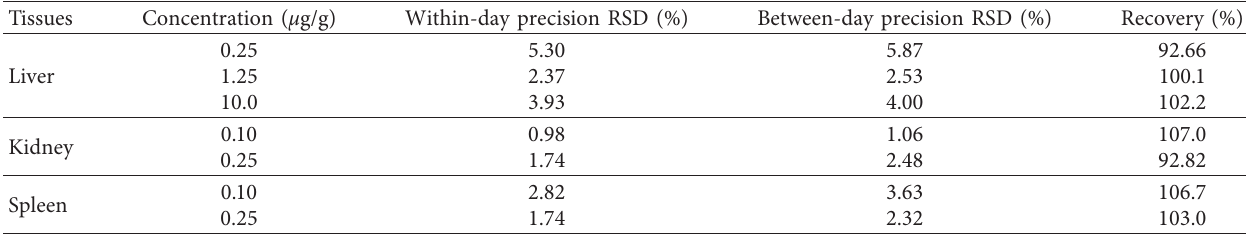
Table 2: Precision and accuracy of the method ( n � 6).